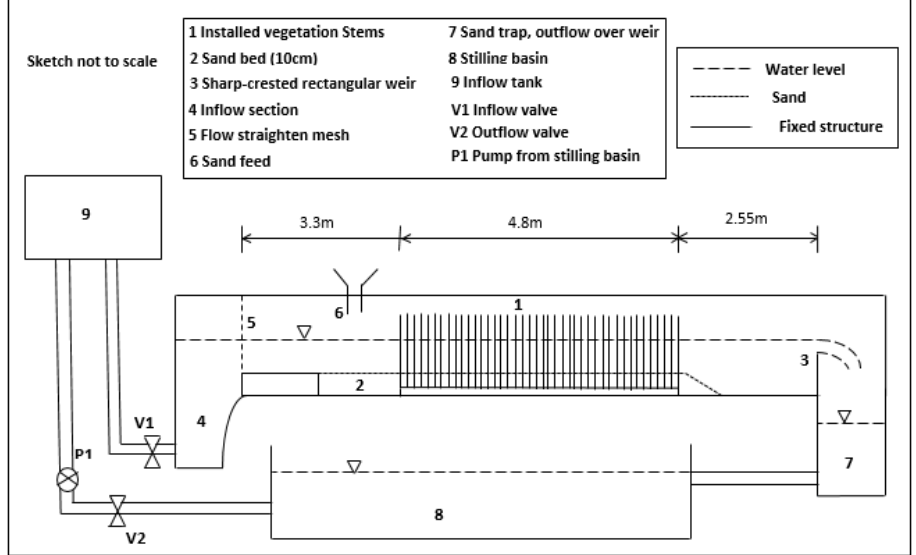
Figure 2. Flume setup.